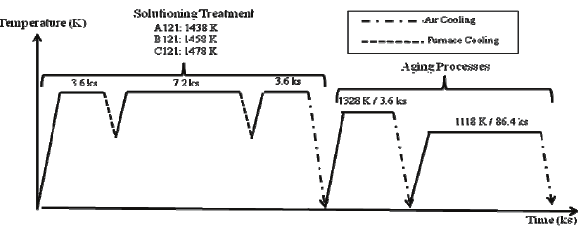
Figure 10. Simulated reheat treatment programs: A121, B121 and C121.